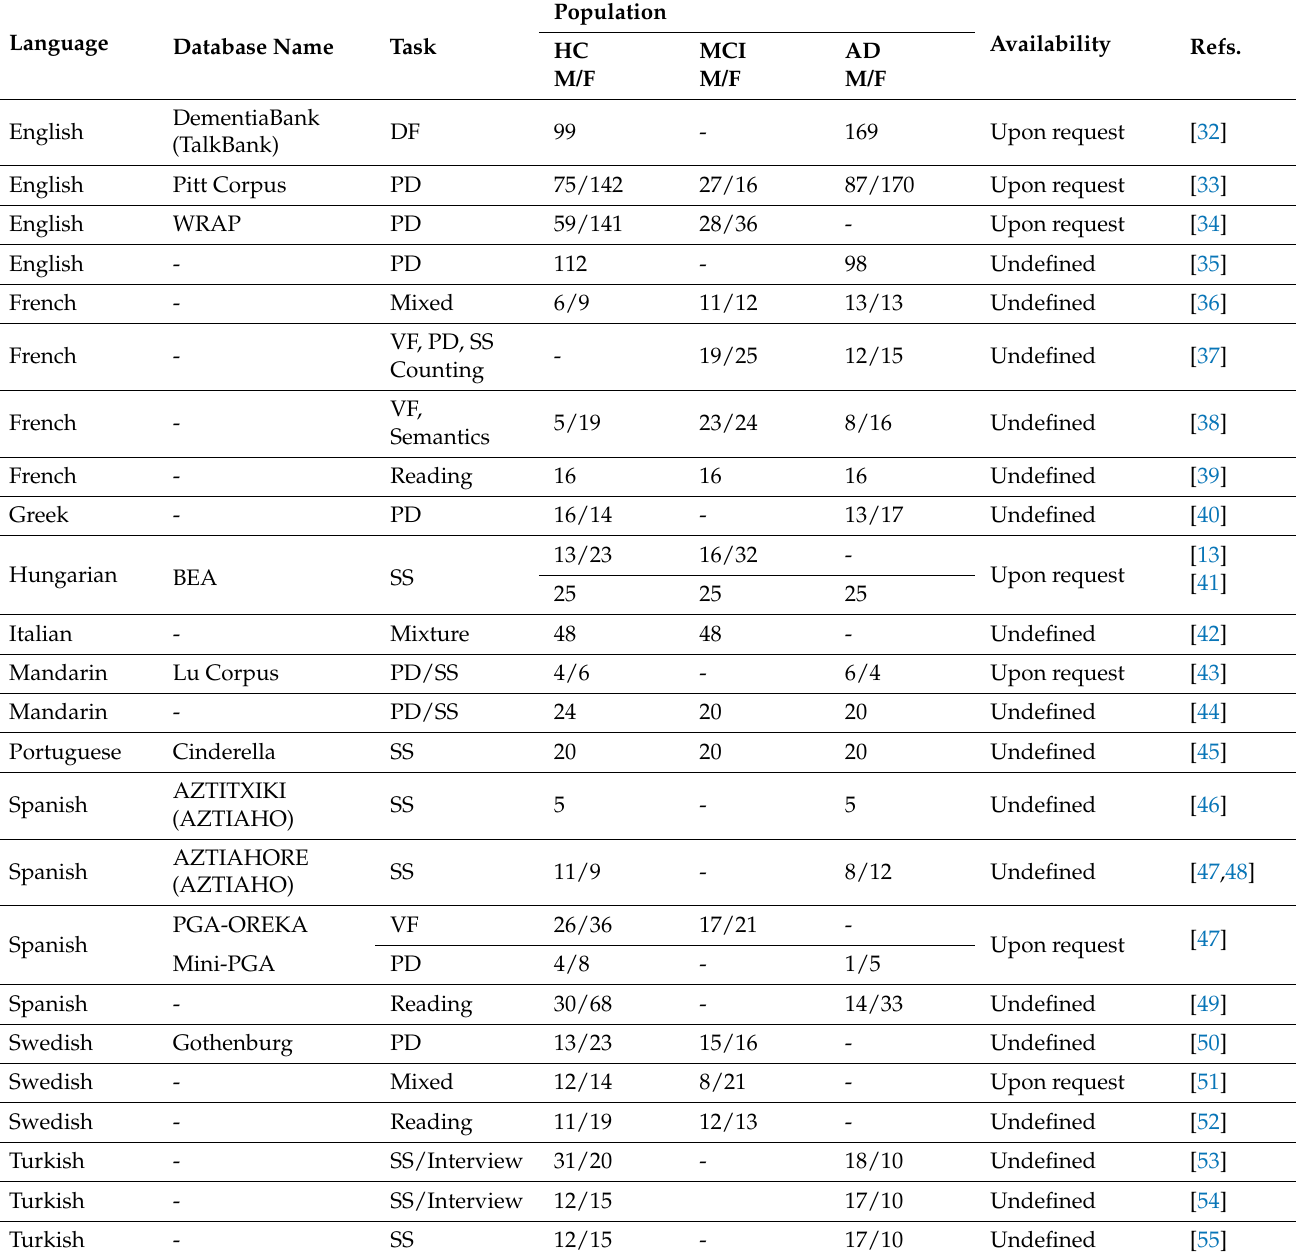
Table 2. List of databases, with related specifications, with Alzheimer’s patients’ speech recordings. (Table contents are sorted by language, first column, and database name, second